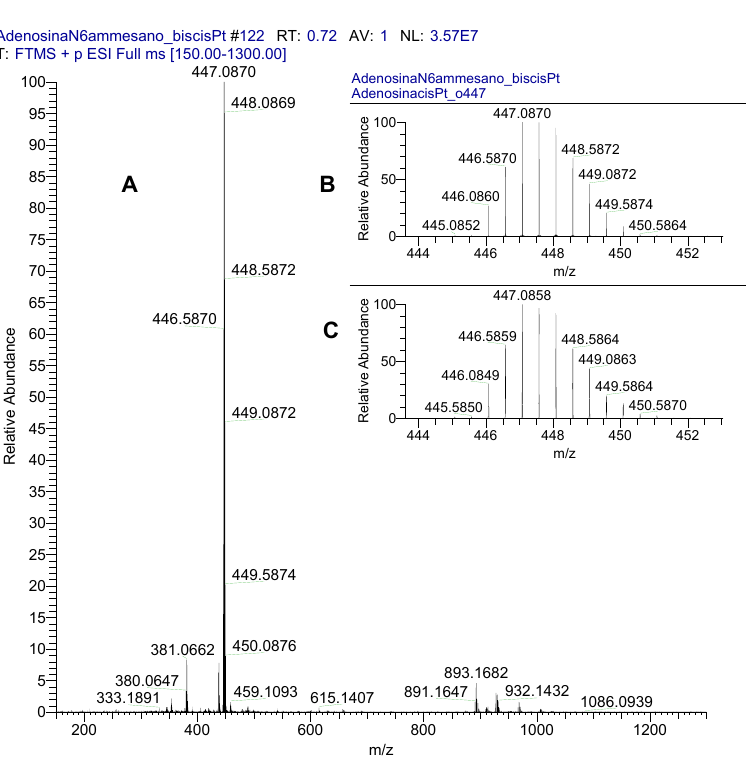
Figure 2. HRMS spectrum of complex 8a (panel A ). Expansion of the isotopic pattern of the base peak (panel B ) and of the corresponding calculated one (panel C